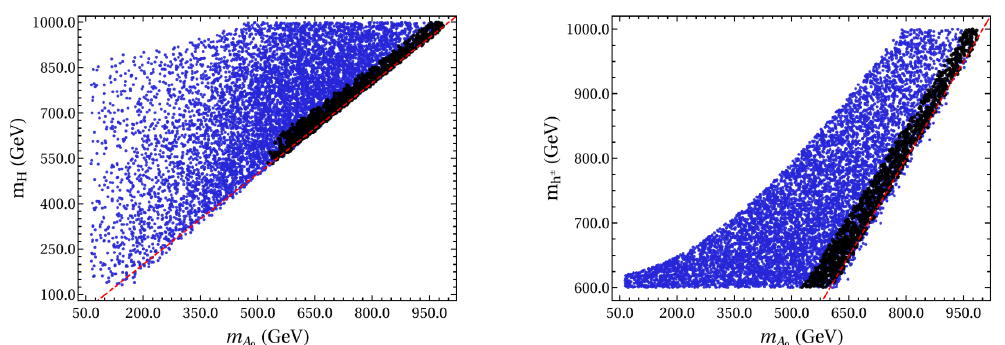
Figure 10 . In both figures, blue points complies with theoretical constraints ath the EW scale, while for the black points we choose the scale v χ = 100 TeV . The dashed red line is for degenerate